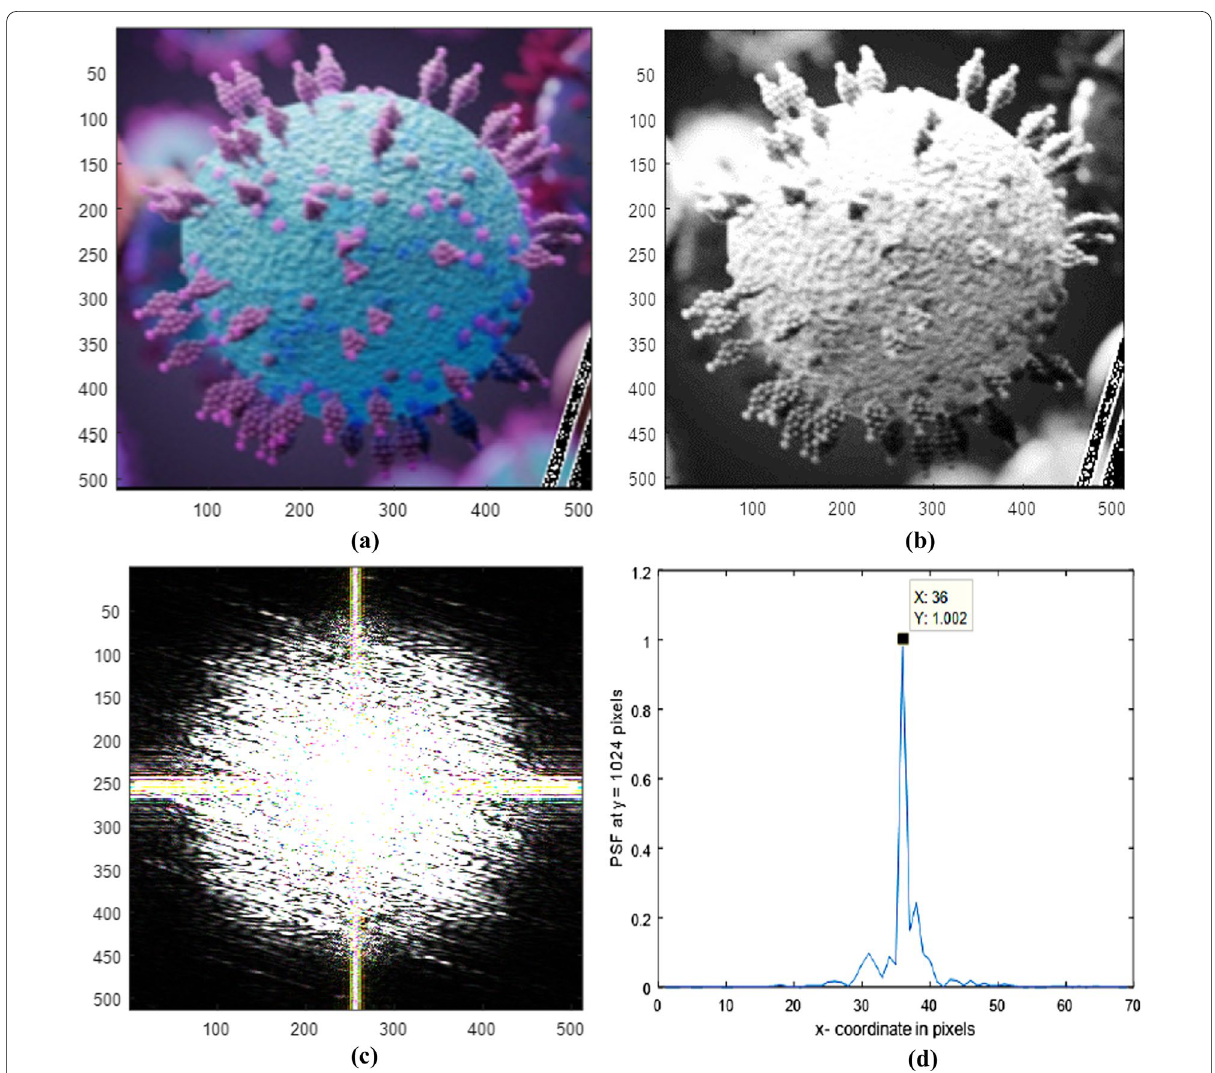
Fig. 6 a Color image of omicron corona virus image with spikes in a matrix of dimensions 512 virus image with spikes in a matrix of dimensions 512 the omicron covid 19, shown in b , of matrix dimensions 512 corresponding to the Omicron corona virus image shown in ( a